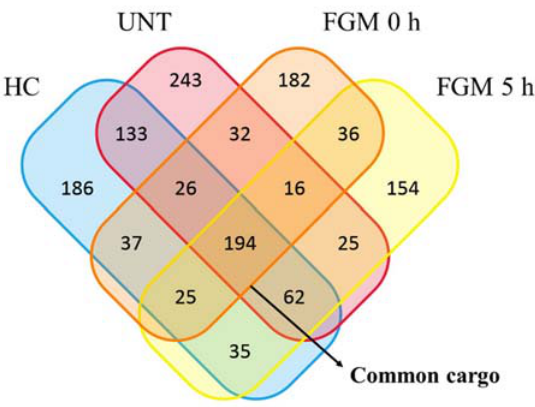
Figure 5. Common cargo of sncRNAs in EVs. Venn diagram shows the number of sncRNAs present in each group, and the common ones among groups. The sncRNAs present in all groups are defined as the “common cargo”. HC: healthy controls; UNT: untreated multiple sclerosis patients; FGM 0 h: fingolimod previous first dose; FGM 5 h: fingolimod 5 h after first dose.